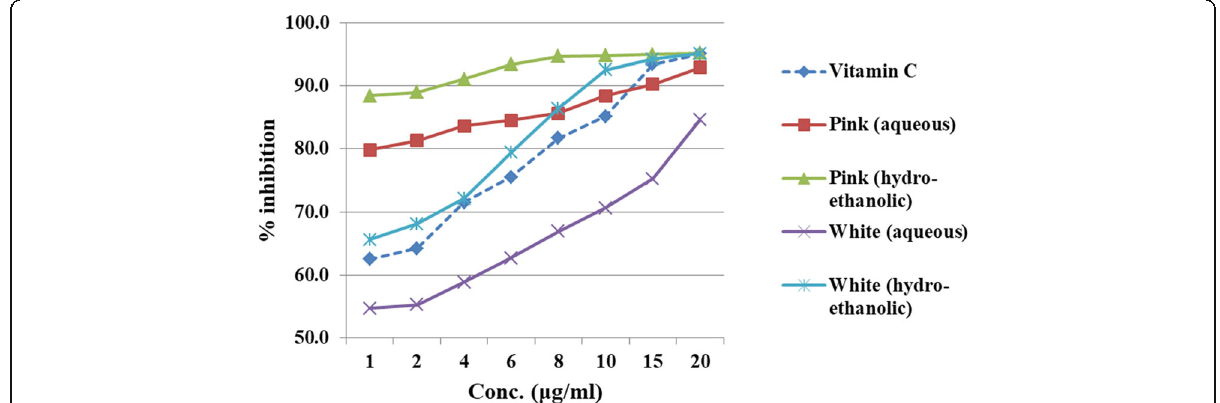
Fig. 2 Ferric reducing power of standard and various formulations of guava leaf